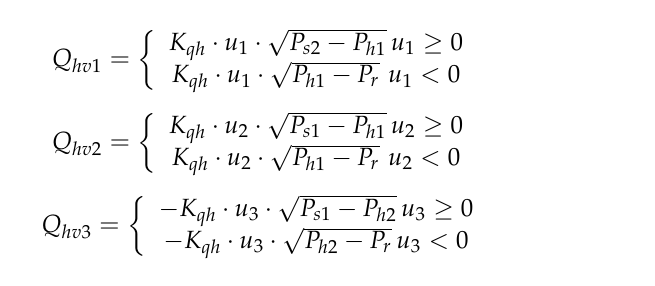
where V h 1 = V h 10 + A 1 x ph , V h 2 = V h 20 − A 2 x ph , V h 1 and V h 2 are the hydraulic cylinder volume without the rod and with the rod; V h 10 is the volume of the cavity between the valves and the hydraulic cylinder without the rod in the initial position, V h 20 is the volume of the cavity between the valves and the hydraulic cylinder with the rod; P h 1 and P h 2 are the hydraulic cylinder pressure without rod and with the rod; x ph is the hydraulic cylinder displacement; Q h 1 is the flow entering into the cylinder chamber without the rod; Q h 2 is the flow leaving the cylinder chamber with the rod; A 1 and A 2 are the hydraulic cylinder areas without the rod and with the rod; β e is the bulk modulus of hydraulic oil.